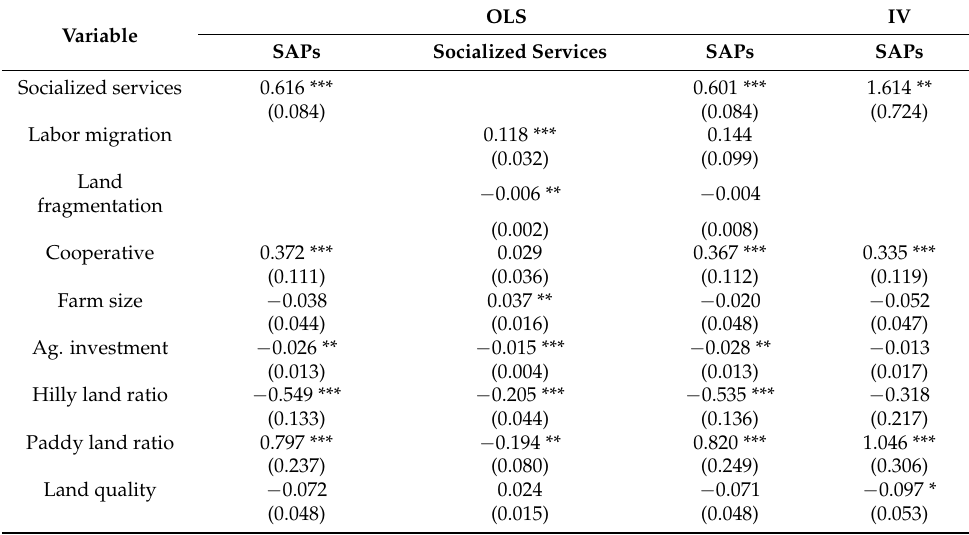
Table A1. Results of validity test of the